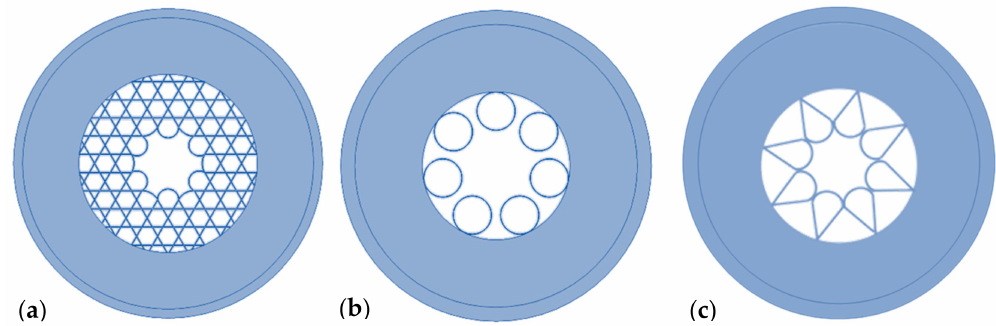
Figure 1. Depictions of common large-area hollow core fiber designs: ( a ) Kagome-type fiber; ( b ) single ring- or revolver-type fiber; and ( c ) cone-type